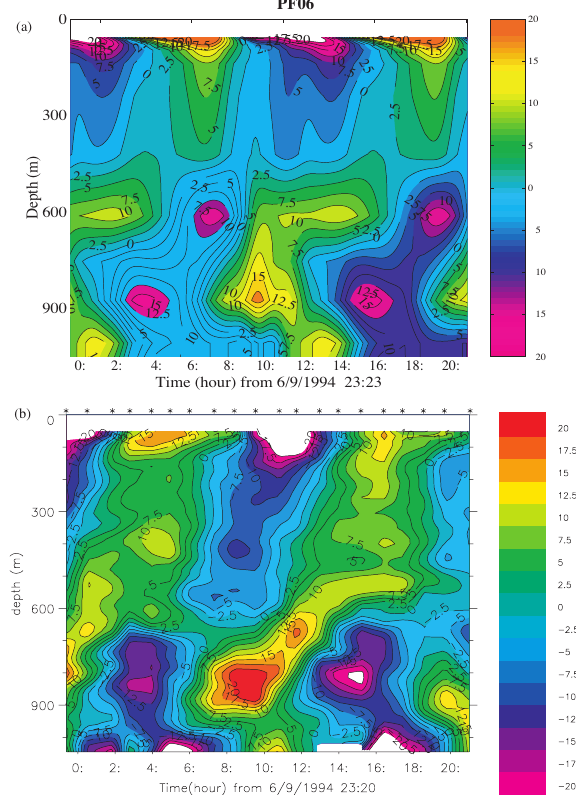
F IG . 15. – Time series of north-south baroclinic velocity at the PF06 location from the model (a) and from lowered ADCP measurements (b) during two semi-diurnal tidal cycles (25